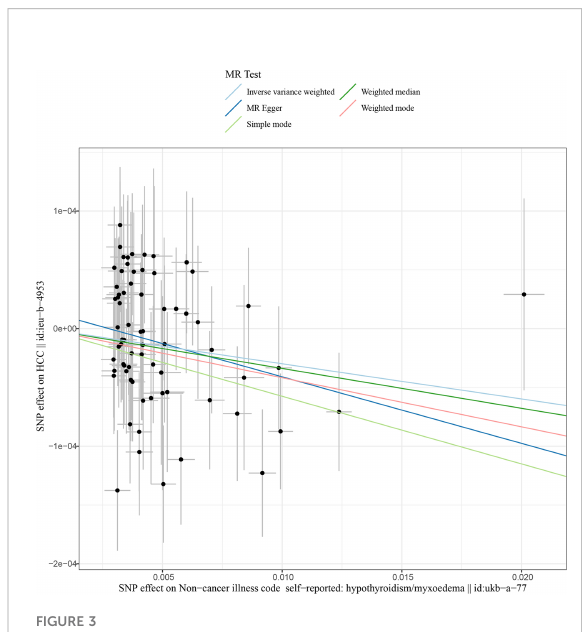
FIGURE 3 Scatter plots of Hypothyroidism with the risk of HCC. Scatter plot demonstrating the effect of each hypothyroidism-associated SNP on HCC on the log-odds scale. The slopes of each line represent the causal association for each method. MR, Mendelian randomization; SNP, single-nucleotide polymorphism; HCC, Hepatocellular carcinoma.